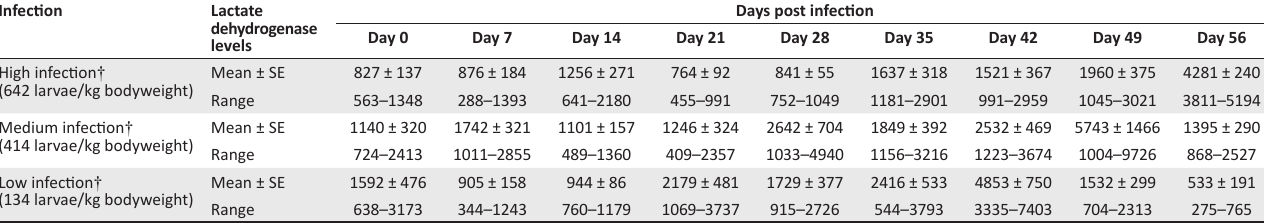
TABLE 6: Mean lactate dehydrogenase levels (IU/L) of Nile crocodiles ( Crocodylus niloticus ) experimentally infected with Trichinella zimbabwensis.